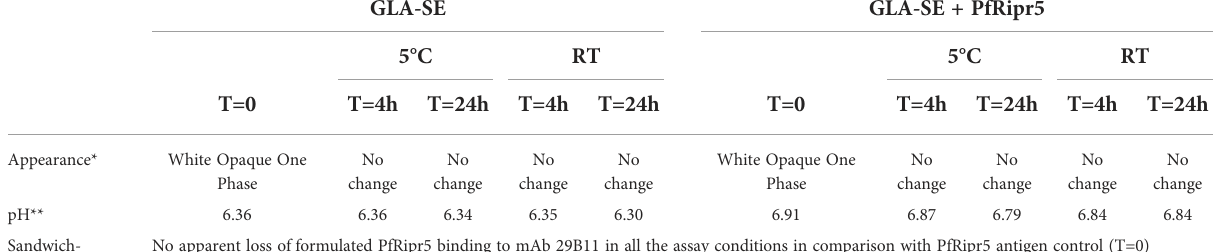
TABLE 3 Formulation of PfRipr5 with